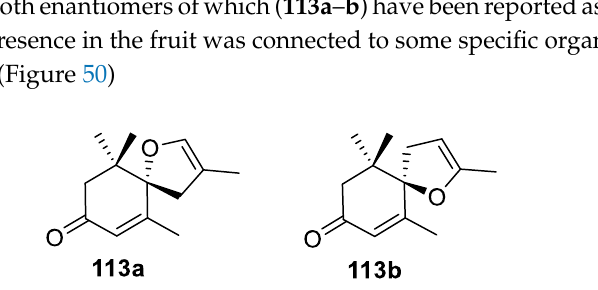
Figure 49. Natural spirocyclic tetrahydrofurans.